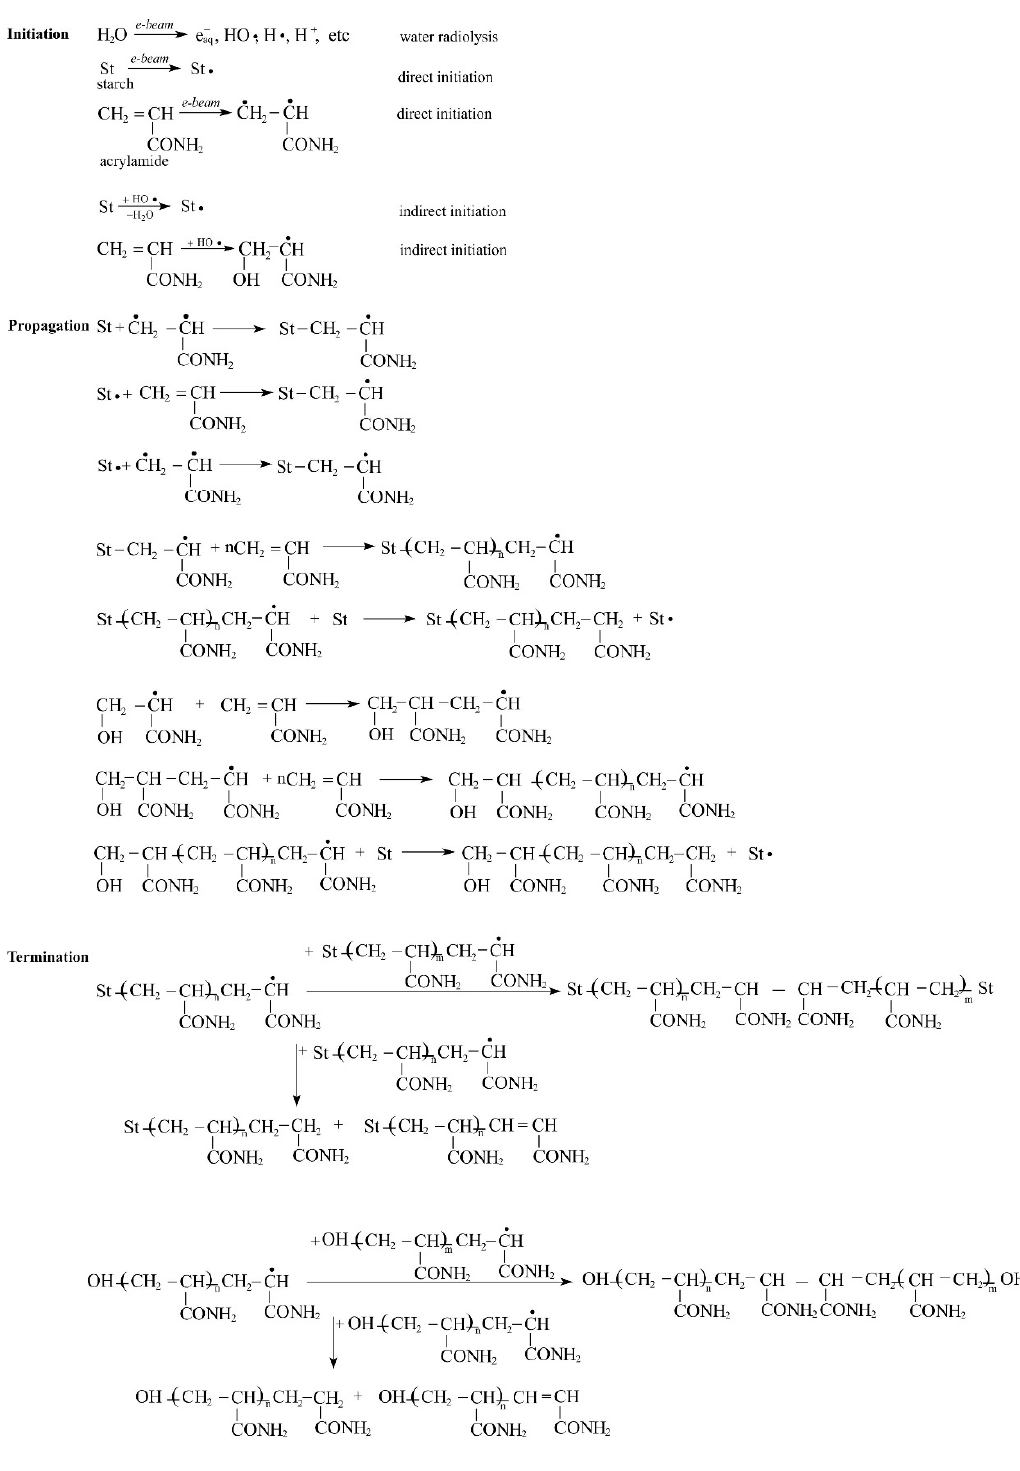
Scheme 2. Mechanism of starch grafting by using electron beam